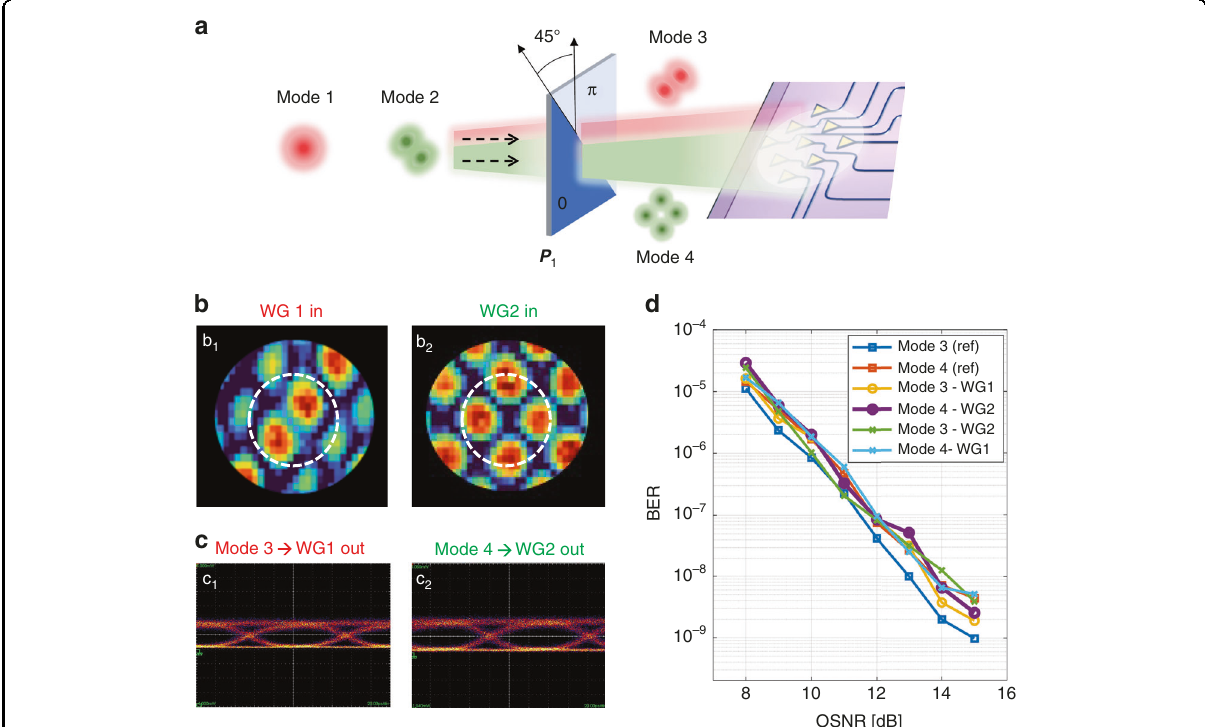
Fig. 4 Mode separation after a controllable mode-mixing. a Schematic representation of two free-space modes (Mode 3 and Mode 4) that arrive on the receiver after a mode conversion performed by a 45°-rotated phase mask. In the reported experiment, Mode 3 and Mode 4 correspond to 45°- rotated HG10-like and HG11-like modes, respectively. b Backward far- fi eld intensity pattern radiated by the 2D optical antenna array when the photonic processor is con fi gured to couple Mode 3 to WG1 (b 1 ) and Mode 4 to WG2 (b 2 ). Circles indicate the position of the zero-order diffraction. c Measured eye diagrams of two intensity modulated 10 Gbit/s OOK signals simultaneously transmitted by using Mode 3 and Mode 4 for the con fi gurations considered in ( b ). d BER measurements of 10 Gbit/s OOK channels simultaneously transmitted in the free space on spatially overlapped modes (Mode 3 and Mode 4) and separated by the photonic processor. Blue and red squares indicate the reference BER of individually transmitted